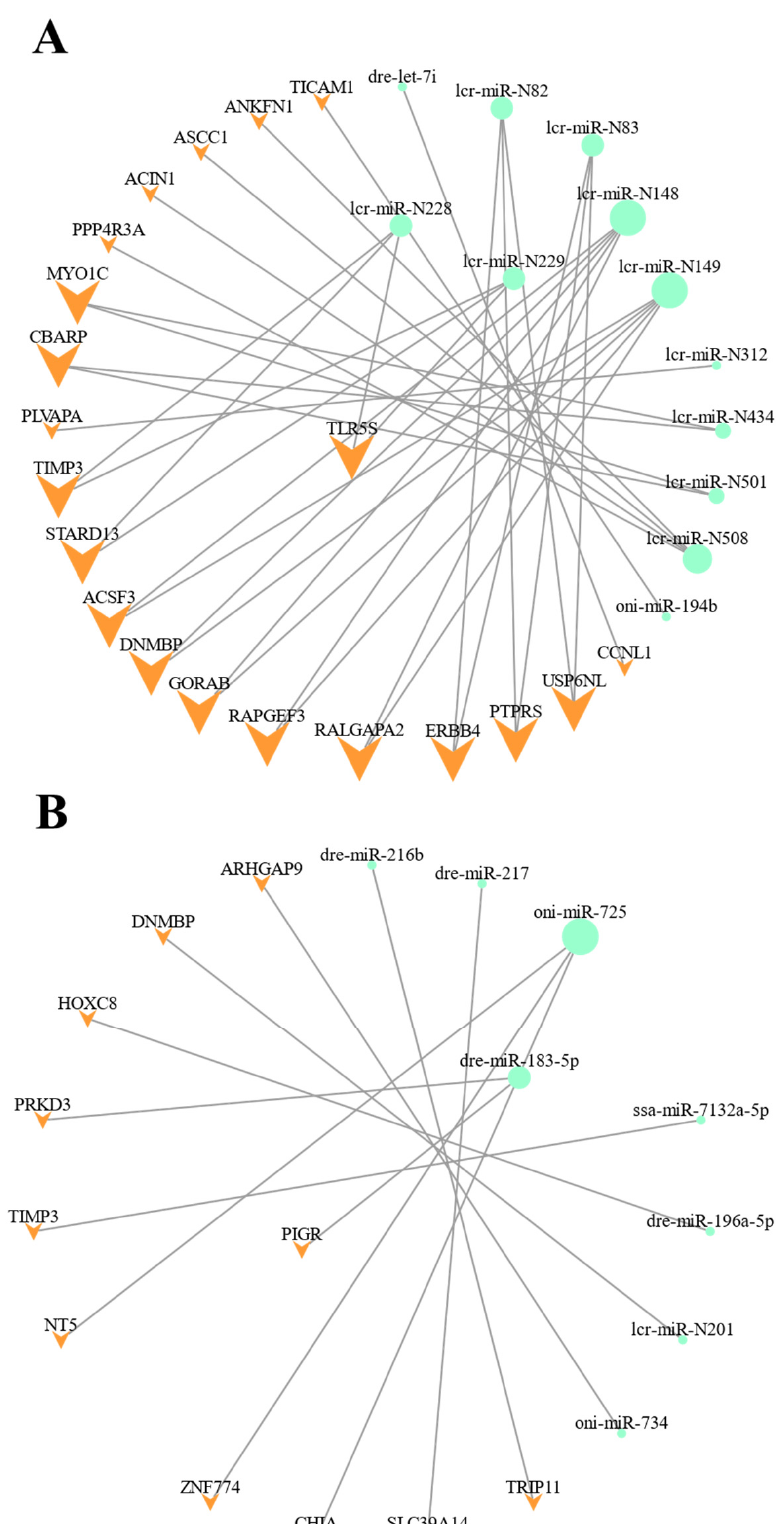
Figure 5. The DEmiRNA-DEmRNA regulatory networks identified in spleen of L. crocea at 12 h ( A ) and 24 h ( B ) after P. plecoglossicida challenge. DEmRNAs are represented by orange arrowheads, and DEmiRNAs are represented by green circles. Shape size reflects the number of associated edges (i.e., larger shapes have a greater number of connections).